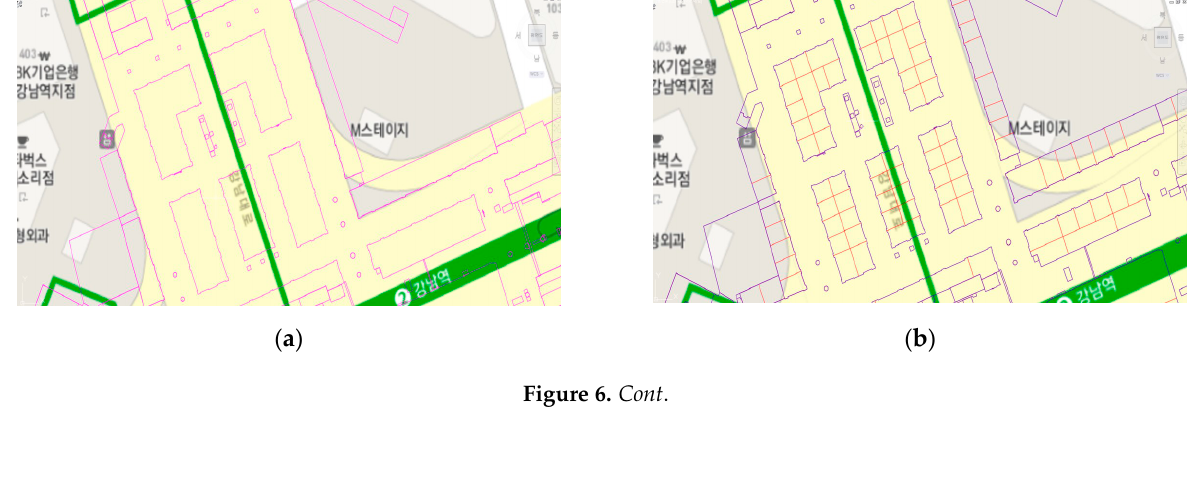
( d ) Figure 6. 3D spatial data generation using VWorld data. ( a ) VWorld raw data. ( b ) Store unit object generation. ( c ) At- tribute information input. ( d ) 3D modeling (3DS). 4. Discussion The public underground shopping center is the target of registration in this study. The public underground shopping center is a shared property of the local government which holds the ownership, and the stores are generally operated by the store owner [20]. Therefore, in this study, the underground shopping center and individual stores are the targets of registration to protect the ownership held by the local governments and the lease rights of the store owners for individual stores. In general, because the property rights for land in Korea are set based on above-ground parcels, it is necessary to register the entire underground shopping center space and individual store spaces, along with the physical and rights relation, with the above-ground parcel when registering underground spaces. In terms of physical relation, the spatial scope of the underground shopping center or the individual store occupying the underground space is the target of registration, and it is necessary to specify which parcel the corresponding underground space is located under. In terms of rights, the party, purpose, area, rights relation (owner, tenant, period, price, etc.) of the property rights, and changes in the physical and rights information need to be included as regis- tration information. 4.1. Building Data on the Spatial Relation between Ground and Underground Space To register an underground space based on the store-level 3D underground space data generated using a survey or pre-built data, the spatial status of the ground and un-